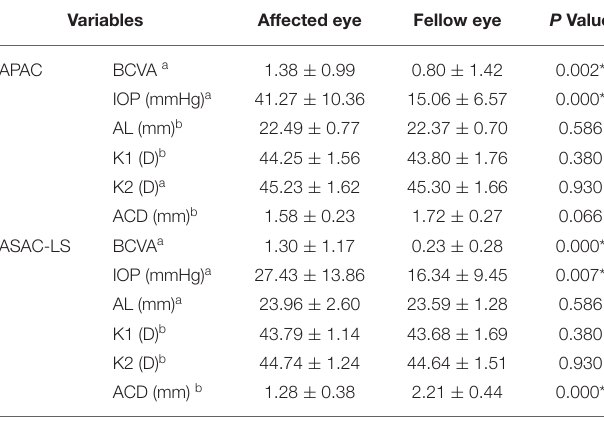
TABLE 1 | The demographic and past histories of the ASAC-LS and APAC cohorts. Variables APAC ASAC-LS P Value